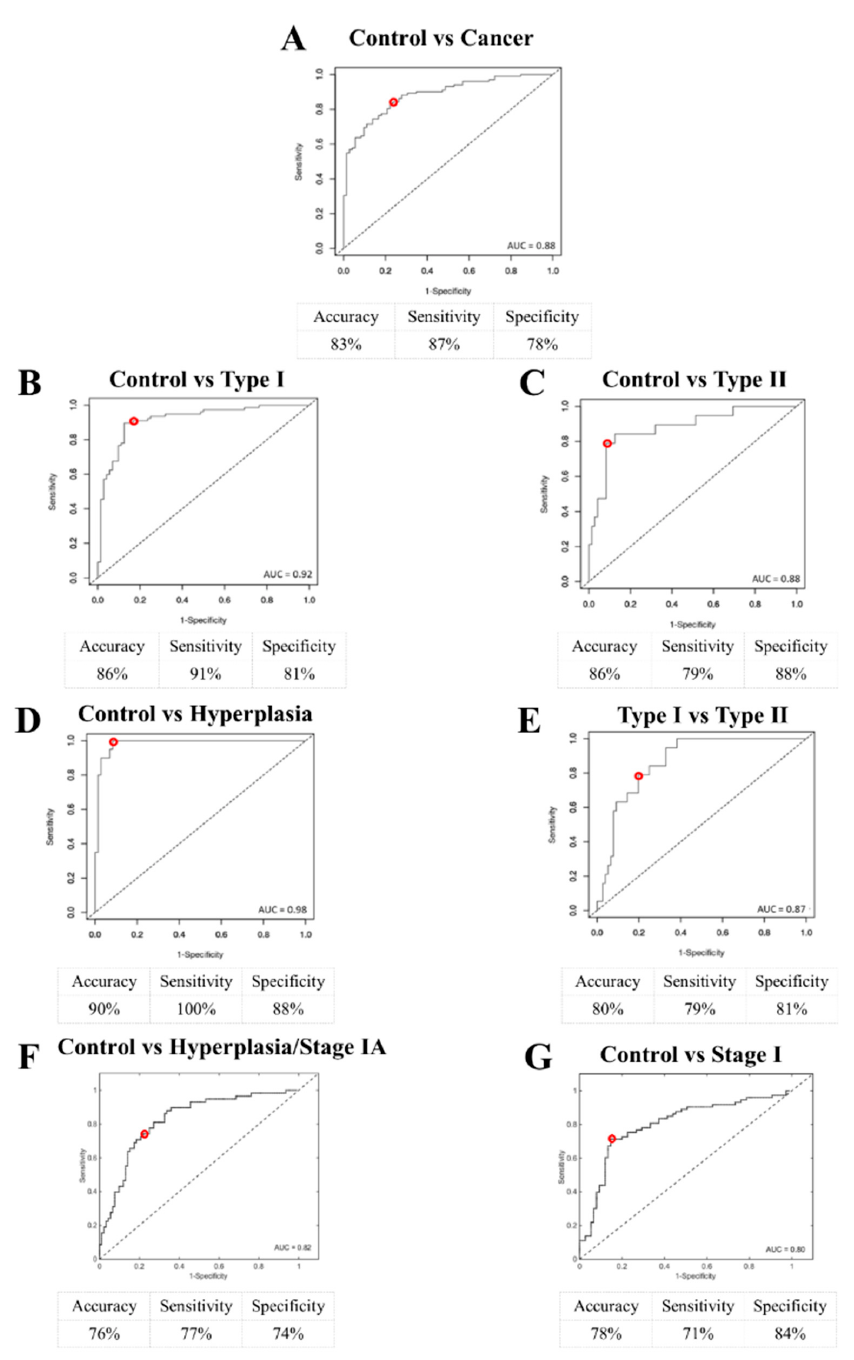
Figure 3. Receiver operating characteristic (ROC) curves along with overall accuracies, sensitivities, specificities and area under the curve (AUC) values after supervised partial least squares discriminant analysis (PLS-DA). ( A ) Control ( n = 242) vs. cancer ( n = 342; including Type I ( n = 258), Type II ( n = 64) and mixed ( n = 20)). ( B ) Control ( n = 242) vs. Type I cancers ( n = 258). ( C ) Control ( n = 242) vs. Type II ( n = 64) cancers. ( D ) Control ( n = 242) vs. hyperplasia ( n = 68). ( E ) Type I ( n = 258) vs. Type II cancers ( n = 64). ( F ) Control ( n = 242) vs. hyperplasia/Stage IA cancer ( n = 260). ( G ) Control ( n = 242) vs. Stage I cancer ( n = 254). The red circle denotes the cut-off point for the optimal compromise between sensitivity and specificity.